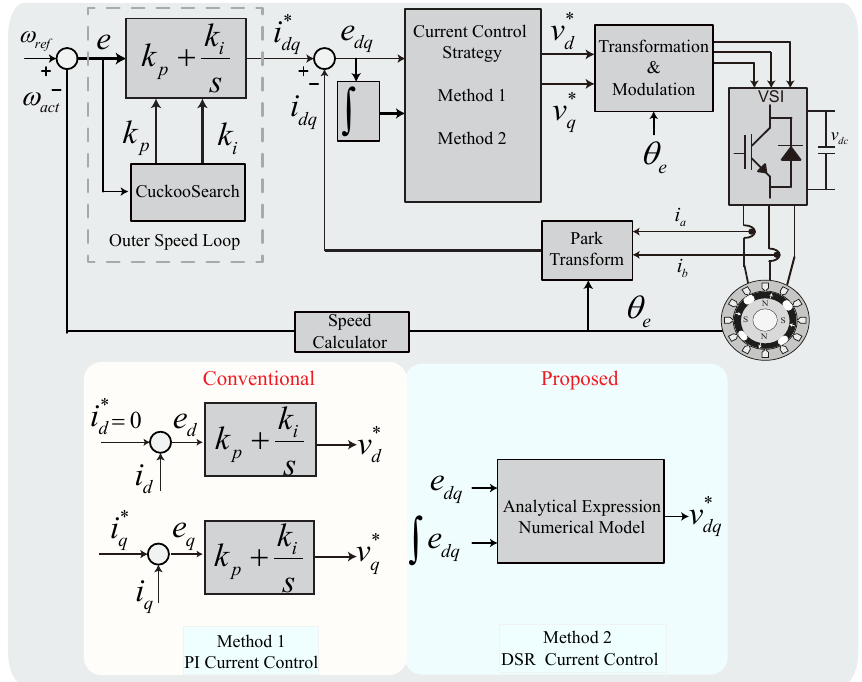
Figure 4. Conventional and proposed field-oriented control architecture of